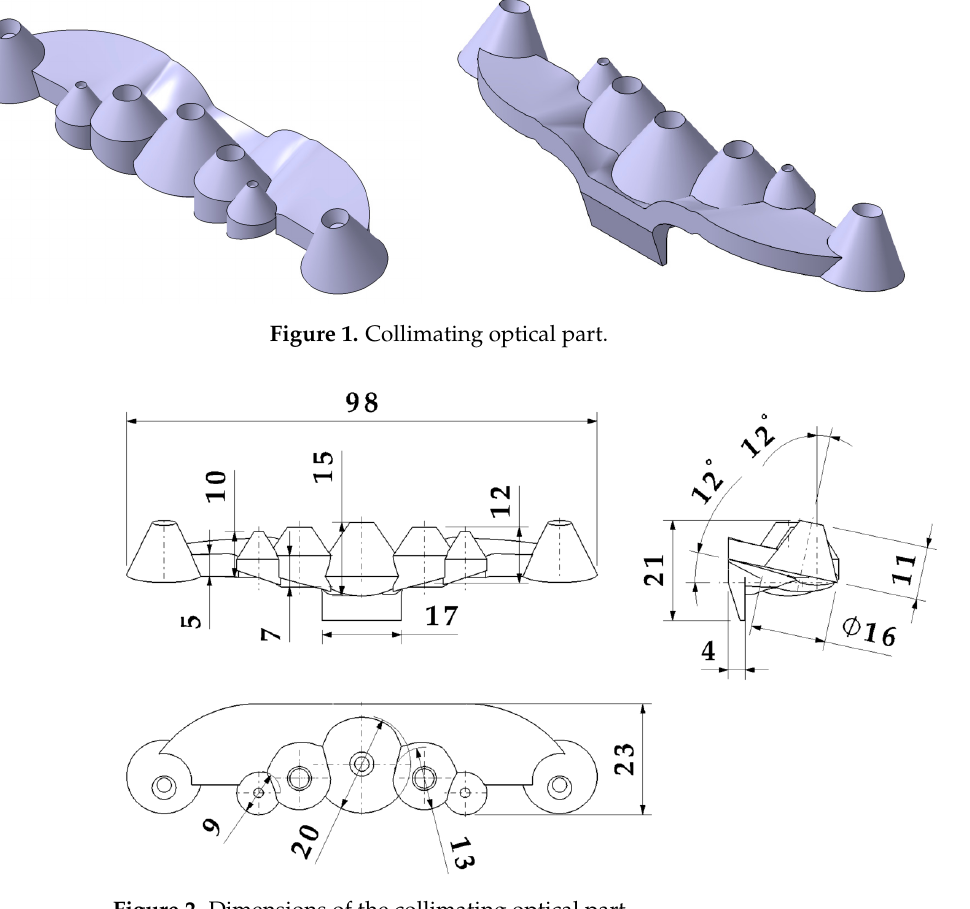
Figure 2. Dimensions of the collimating optical part.